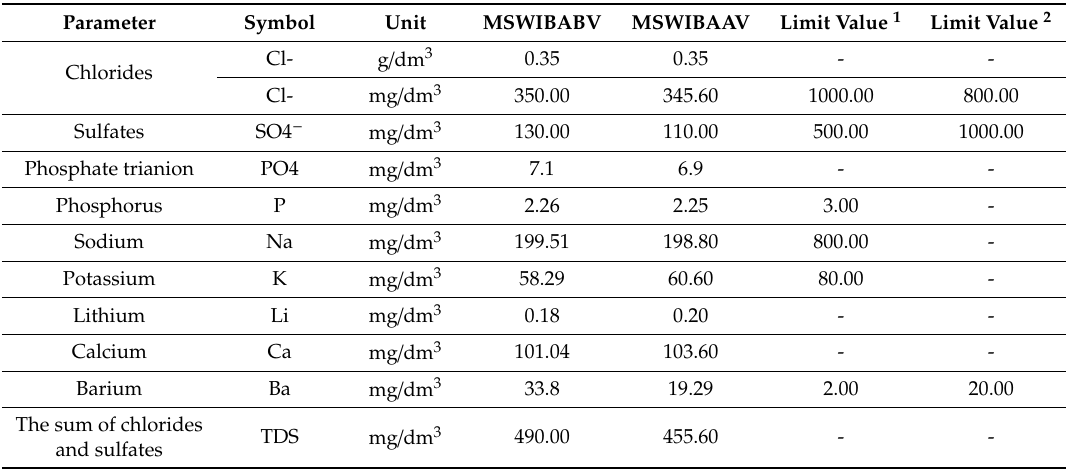
Table 6. Leachability of selected macroelements of bottom slags [28,29].